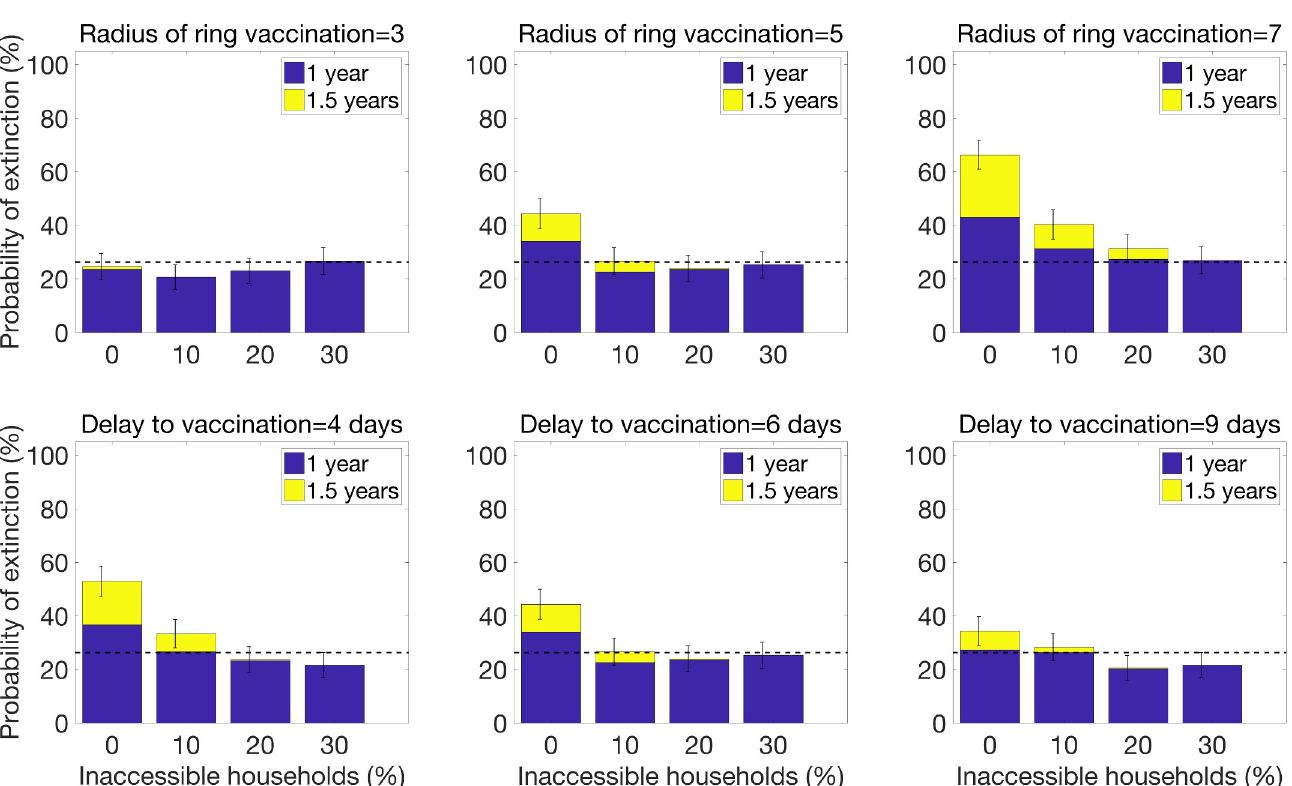
Fig 6. The probability of epidemic control for a ring vaccination strategy as a function of the radius of the ring and the delay to vaccinating contacts. The baseline parameter value for the radius of ring vaccination is the intermediate value of R VR = 5, and the baseline parameter value for the delay to vaccination is the intermediate value of τ = 6 days. Baseline parameter values for other parameters not varied in this figure are given in Table 1.